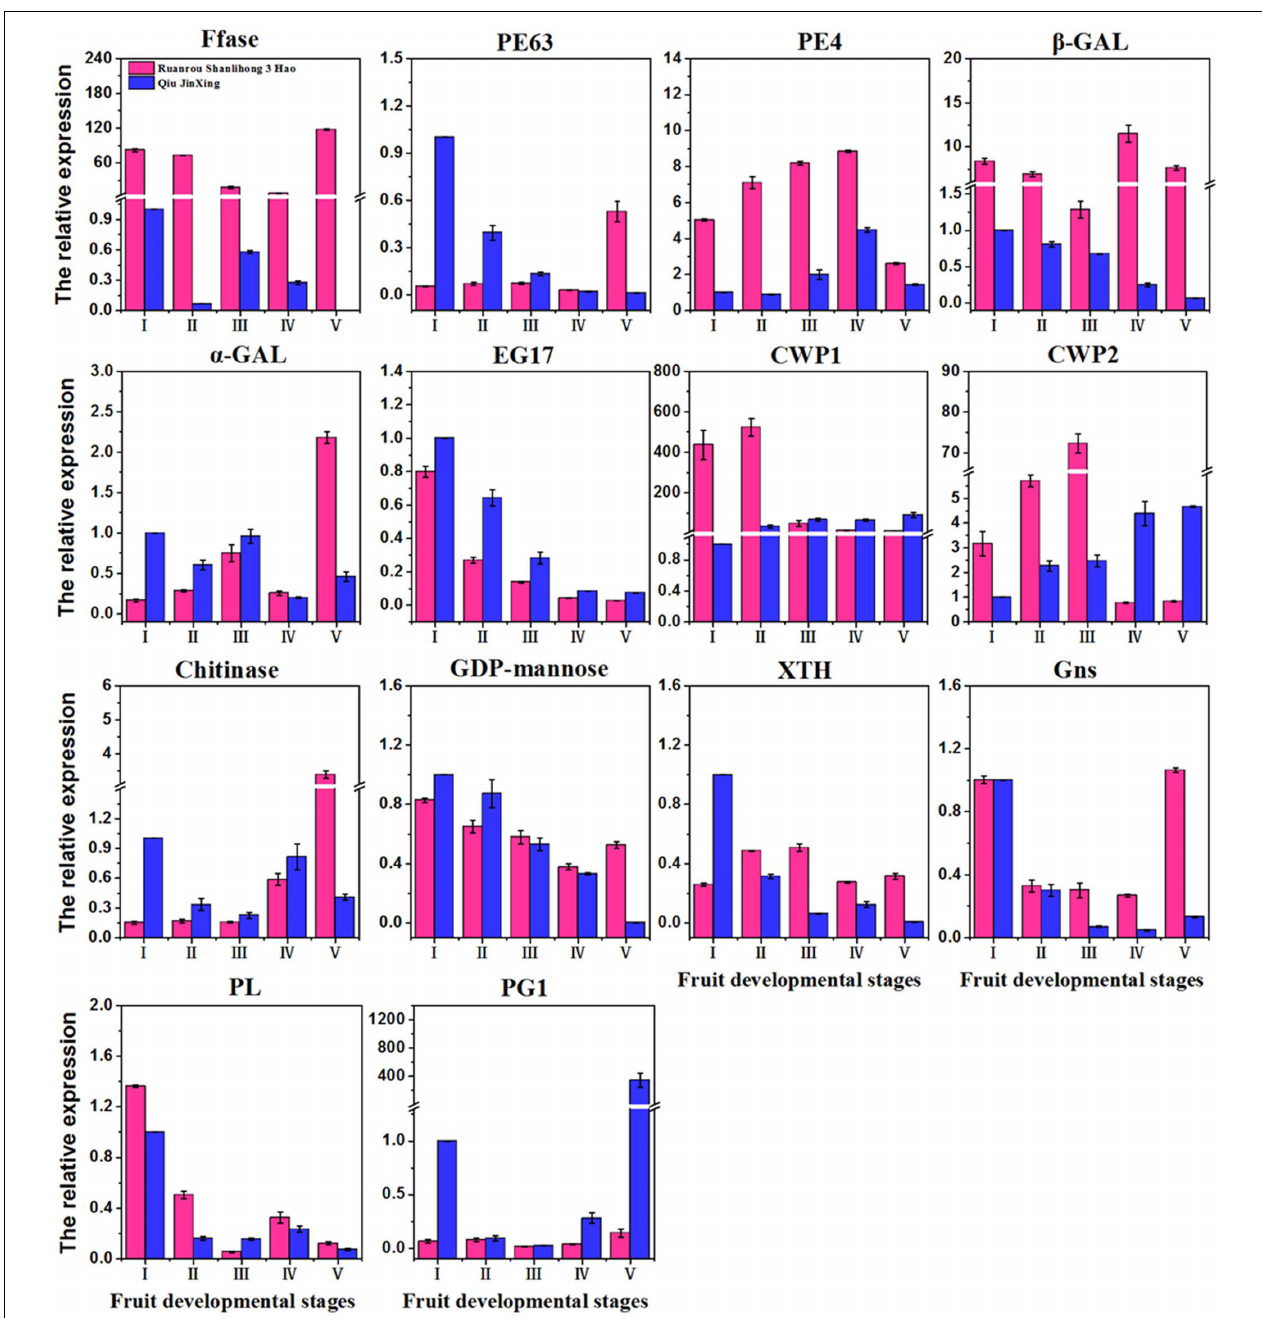
FIGURE 6 | Quantitative real-time PCR validation of 14 DEGs of ‘Ruanrou Shanlihong 3 Hao’ and ‘Qiu JinXing’ fruits. Ffase , β -fructofuranosidase; PE , pectinesterase; β -GAL , β -galactosidase; α -GAL , α -galactosidase; EG , endoglucanase; CWP, cell wall protein; GDP-mannose , glucomannan 4- β -mannosyltransferase; XTH , xyloglucan glycosyltransferase; Gns , glucan endo-1,3- β - D -glucosidase; PL , pectate lyase; and PG ,